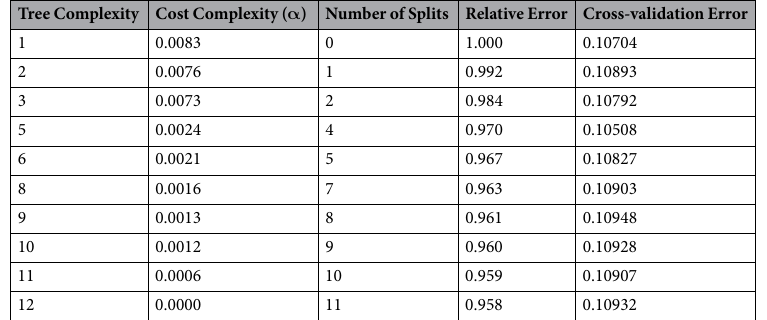
Table 1. The complexity table of recursive partitioning on full iHMP data. Averaged cross-validation measure of the best tree of 100 iterations. Each cell shows the average measure of certain combination of the simulation parameters.